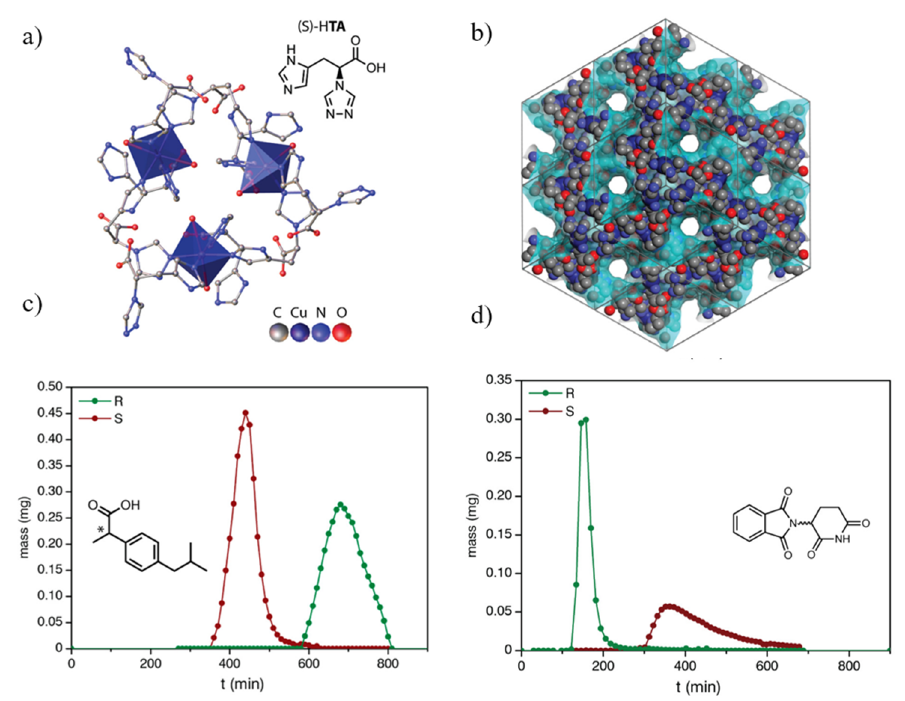
Figure 2. ( a ) Structure of TAMOF–1 and the linker L–2–deaza–2–(4H–1,2,4–triazol–4–yl)histidine (S–HTA). ( b ) Crystal structure on (111) plane, which indicates intersected helicoidal channels ( c ). ( d ) Gravity chromatographic separations of ( ± )-ibuprofen and ( ± )–thalidomide, respectively. Reproduced with permission from [51] Copyright 2019 American Chemical Society.